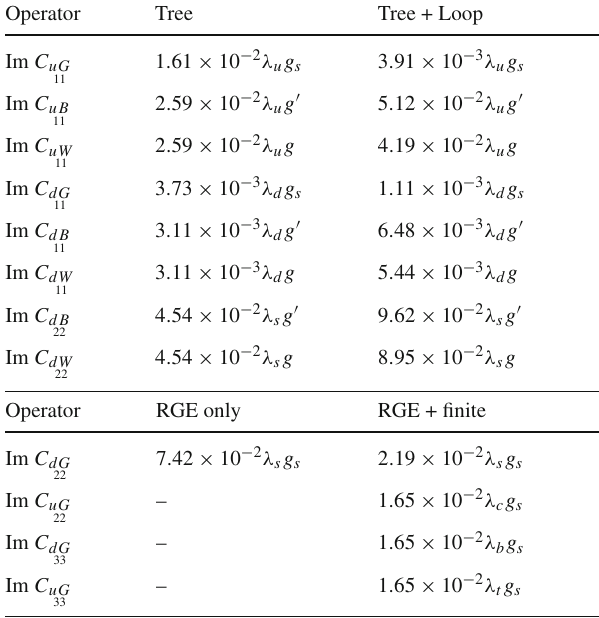
Table 6 Upper bounds on the Wilson coefficients of the dipole opera- tors assuming (cid:2) = 5 TeV and no further assumptions. On the left-hand side the coefficients are presented which can enter at tree level. The col- umn ‘Tree+Loop’ presents bounds including the tree level contribution, the RG running and all finite terms. On the right-hand side one can find all elements which cannot enter at tree level. The left column shows only RG running, while the right column shows both RG running and finite terms. Above, the parameter λ i is the i th diagonal entry of the corresponding diagonalized quark Yukawa matrix here and in all tables that follow